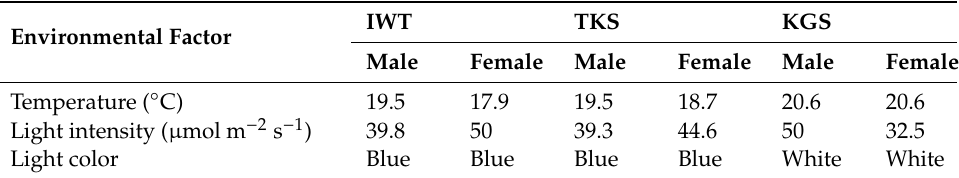
Table 6. The optimized temperature, light intensity, and light color for maturation of male and female gametophytes in the Iwate (IWT), Tokushima (TKS), and Kagoshima (KGS) lines, as predicted by ordered logistic